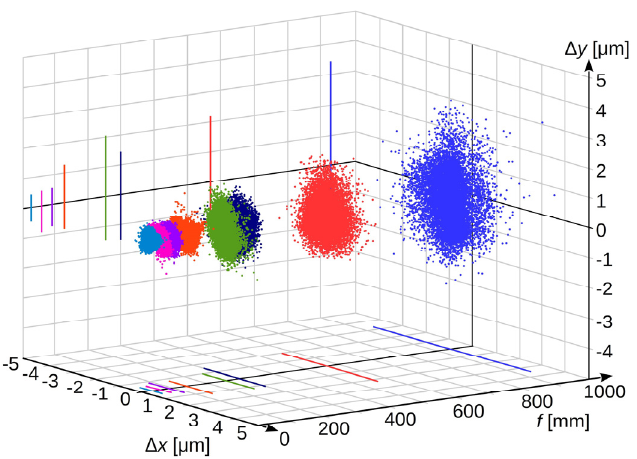
Figure 7. Stochastic deviation of measurement results as a function of lens focal length.